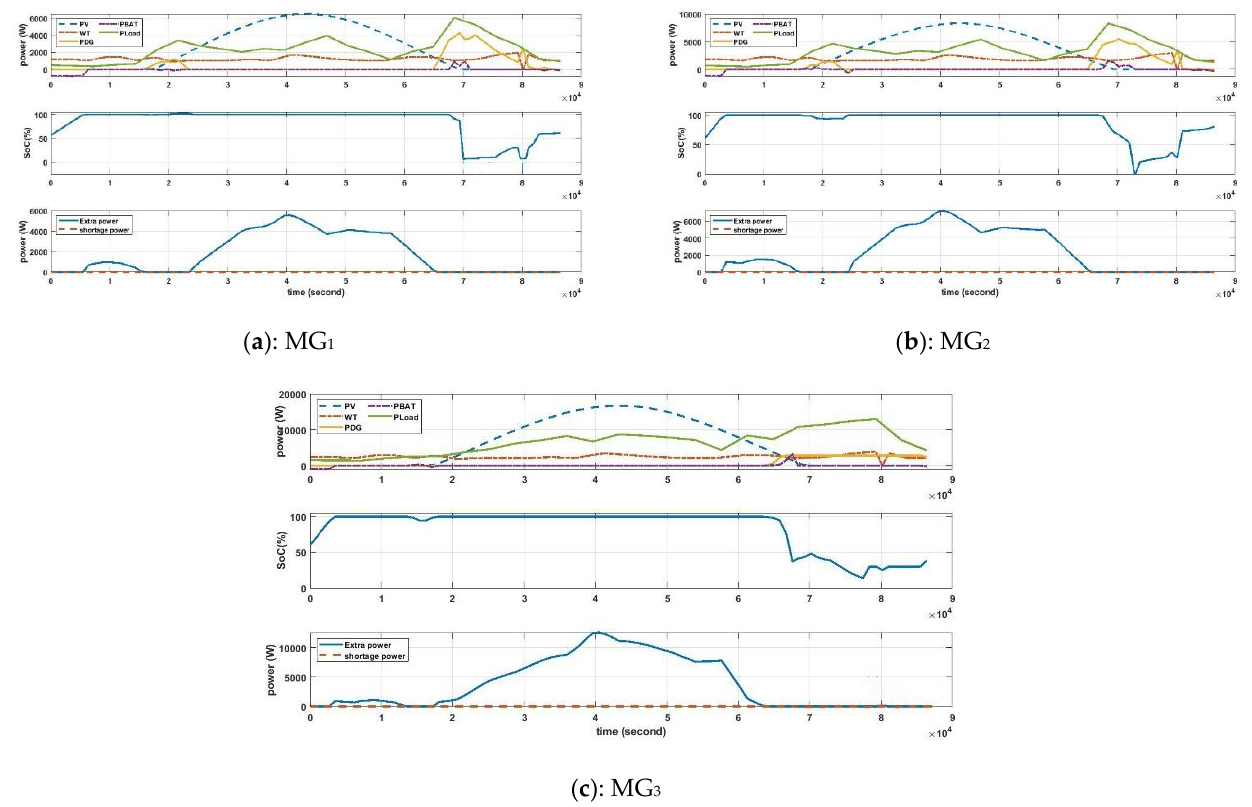
Figure 7. Optimal operation of the HNMGs: ( a ) MG 1 , ( b ) MG 2 , and ( c ) MG 3. Table 6. Optimal operation of the NHMG.